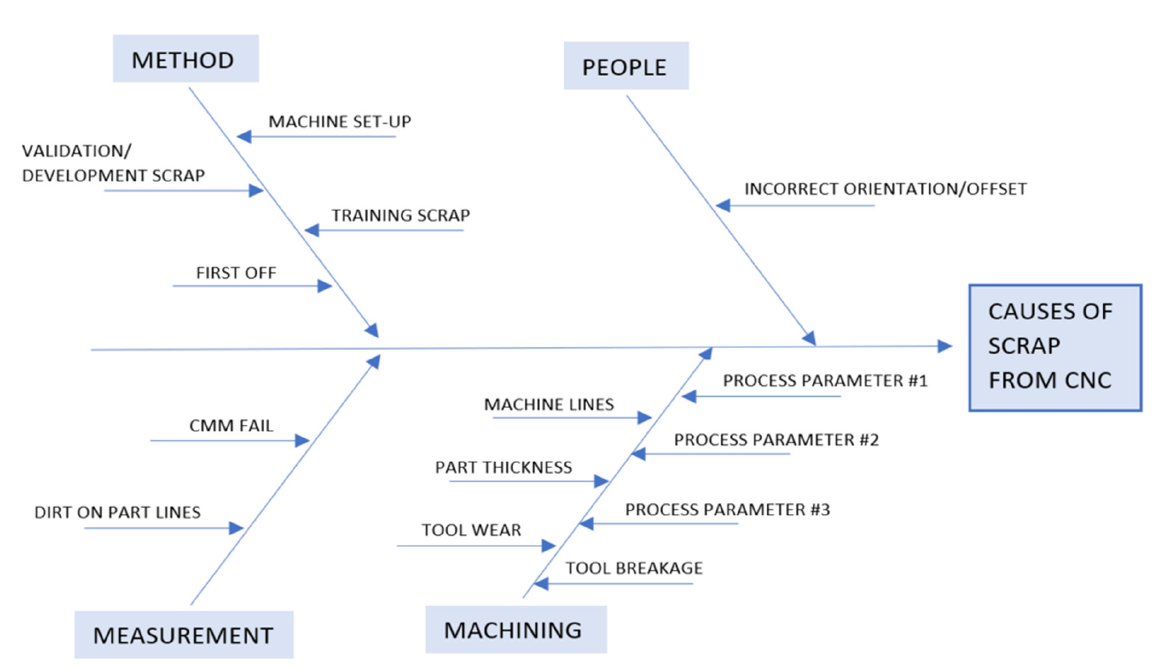
Figure 8. Ishikawa diagram of scrap causes.